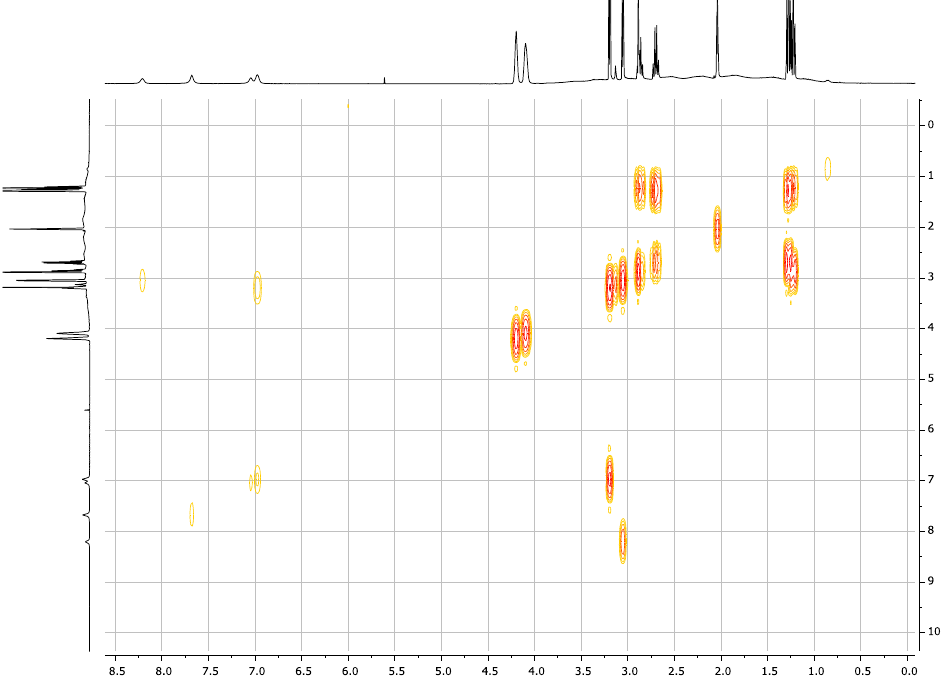
Figure 1. (HH)gCOSY NMR spectrum of amidines 1 in acetone-d 6 . The ratio of 1a : 1b is 1:1.3.